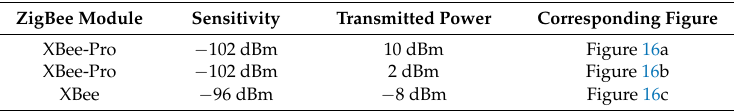
Table 4. 3D Ray Launching